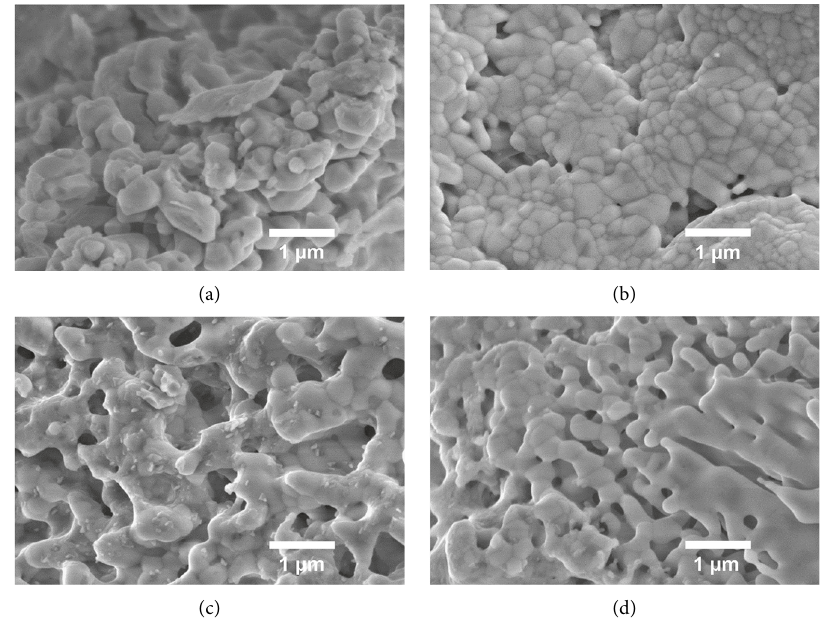
Figure 2: SEM images of Ba 3+ : (a) x � 0.00, (b) x � 0.01, (c) x � 0.03, and (d) x � 1.3 Ca 0.7 − x SiO 4 : x Dy